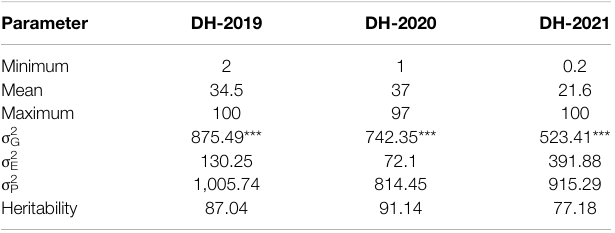
TABLE 2| Basic statistics ofadult plantresponseofbreadwheat DH lines against PstS2 and Warrior pathotypes of stripe rust, estimates of variance components, and broad-sense heritability.